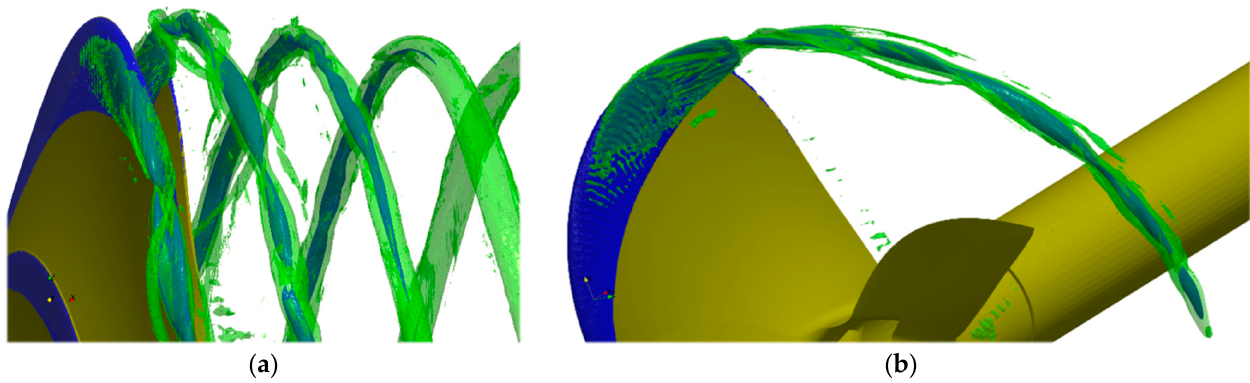
Figure 13. Newcastle. Tip vortex isosurfaces for cavitation α 0.5 (blue) and Q-criterion Q = 5 · 10 4 s − 2 (green): ( a ) overview; ( b ) single vortex view.